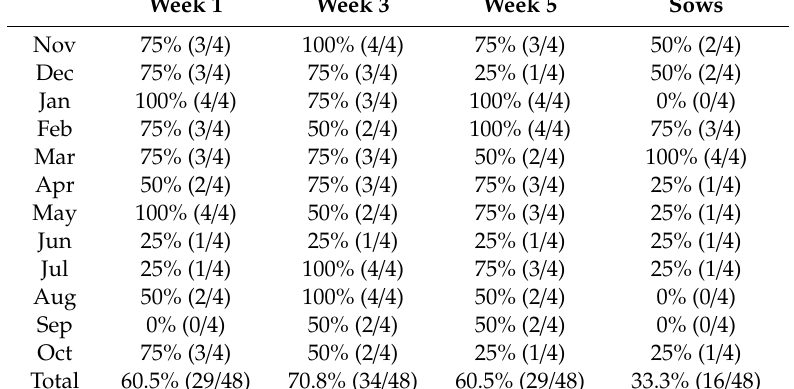
The percentage of swIAV positive samples at week 1, 3, and 5 were based on pooled samples, whereas samples from sows were tested individually.